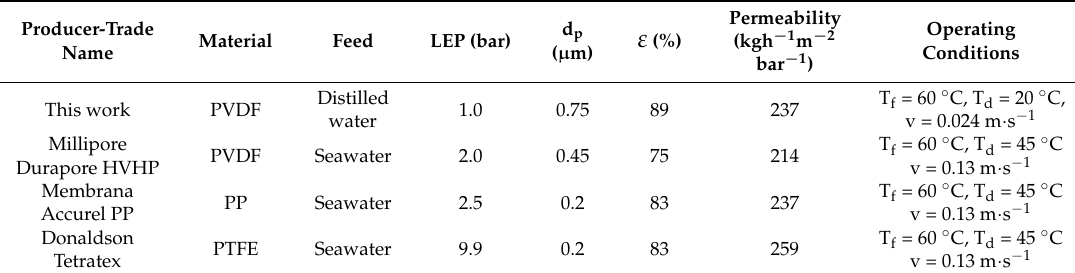
Table 2. Comparison of the permeability values among the membrane produced in this work and those reported in ref. [29].